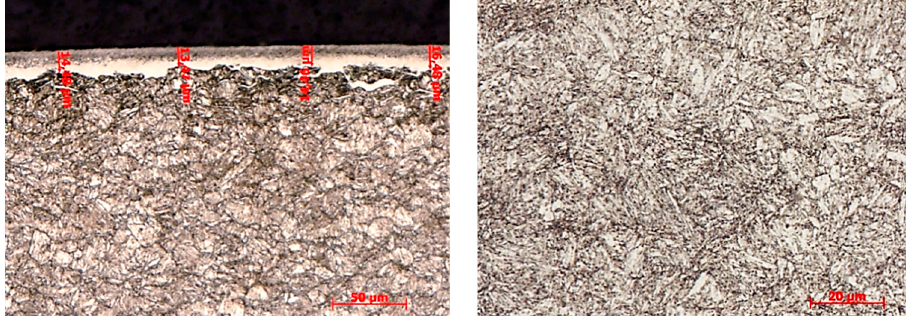
Figure 9. Sample without surface treatment, observation on the edge of the cylinder—magnified 100× ( left ); detail—magnified 500× ( right ).